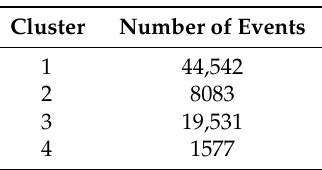
Figure 5. Clustering results: the partition of AE signals on peak frequency–frequency centroid. Table 3. Clustering result: the number of events for four clusters. Table 3. Clustering result: the number of events for four clusters. Table 3. Clustering result: the number of events for four clusters.